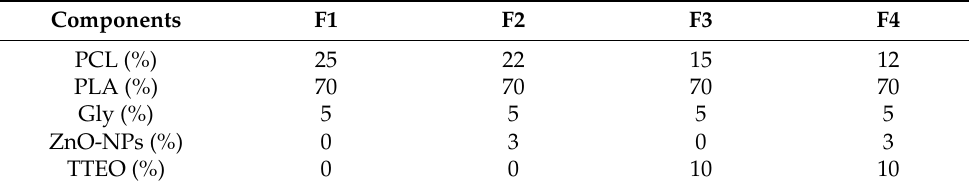
Table 1. Percentage composition (wt.%) for each component in the PCL/PLA/ZnO-NPs/Gly/TTEO